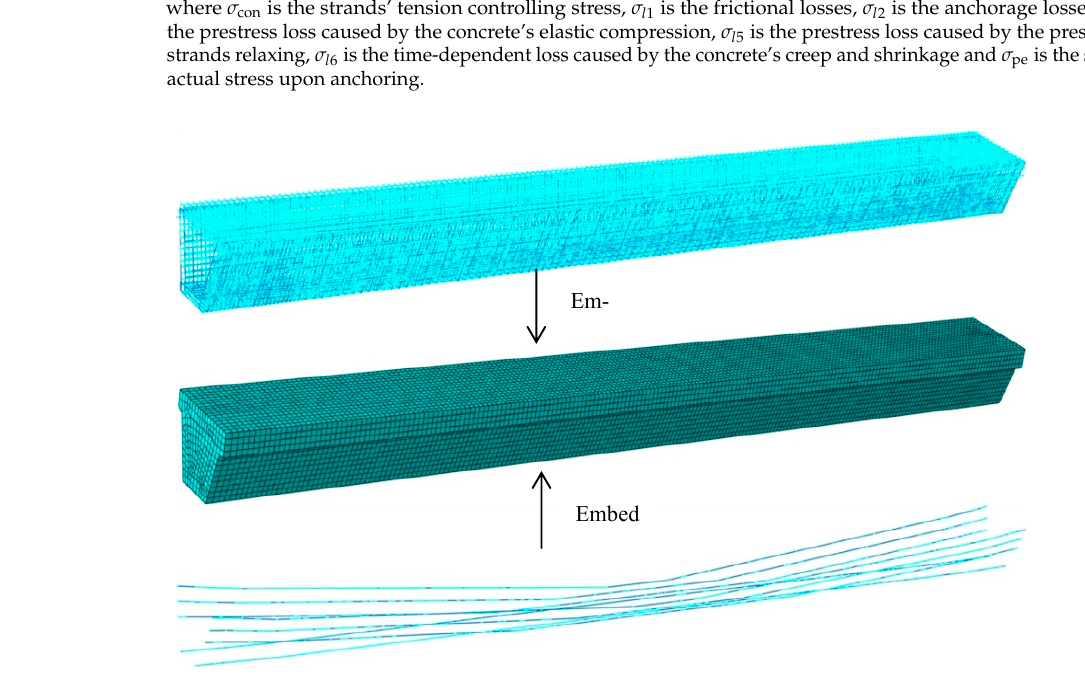
Figure 10. Re fi ned model of the undamaged #3-2 girder. Figure 10. Refined model of the undamaged #3-2